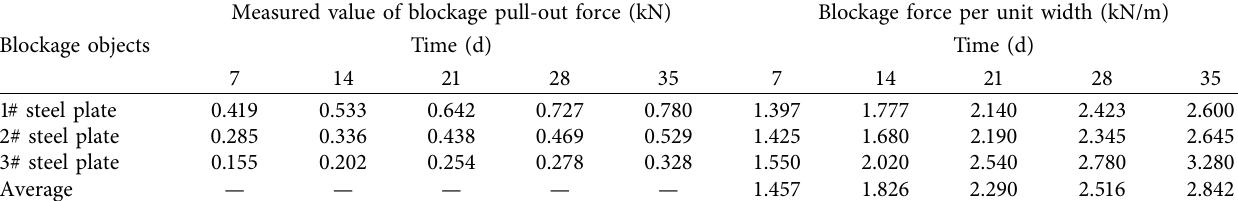
Table 12: Impact analysis of underwater (mixed) siltation time.